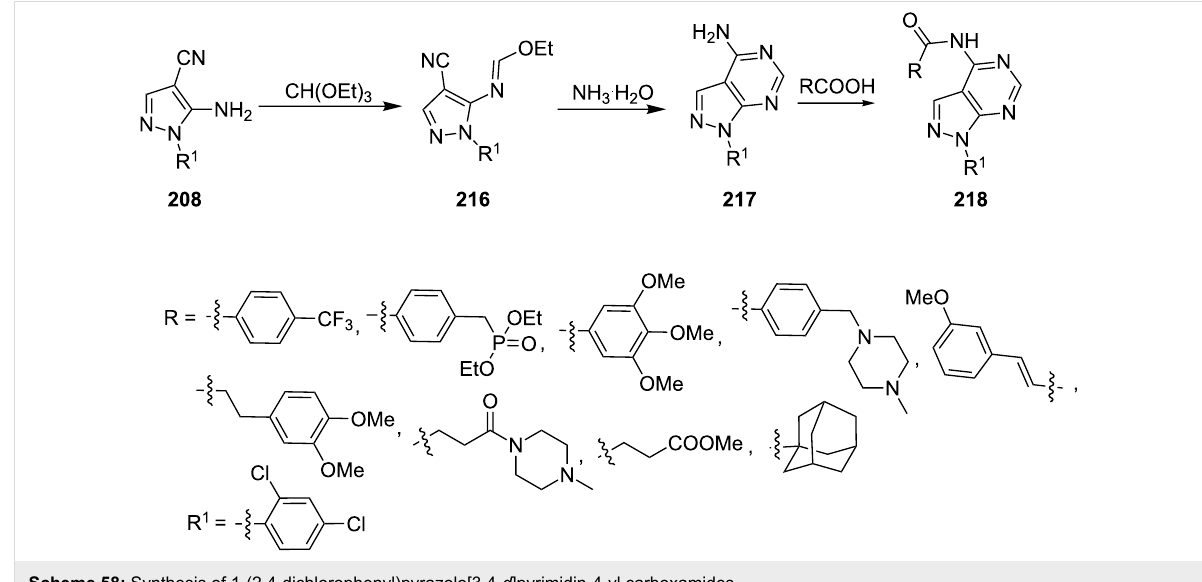
amidines 219 obtained by reaction of 5-amino-4-cyanopyrazole 208 with N , N -dimethylformamide dimethyl acetal (DMFDMA) in acetonitrile at reflux temperature. Amidines 219 were condensed with appropriate 2-amino-5-subsitituted-1,3,4-thia- diazoles 220 under microwave irradiation in acetic acid for the generation of the desired pyrazolo[3,4- d ]pyrimidine derivatives 221 (Scheme 59). The synthesized pyrazolo[3,4- d ]pyrimidines 221 were proved to be good anticancer agents by MTT assay against HL-60 cancer cell lines. Zhang et al. [135] reported the reaction of 5-amino-4-cyanopyr-